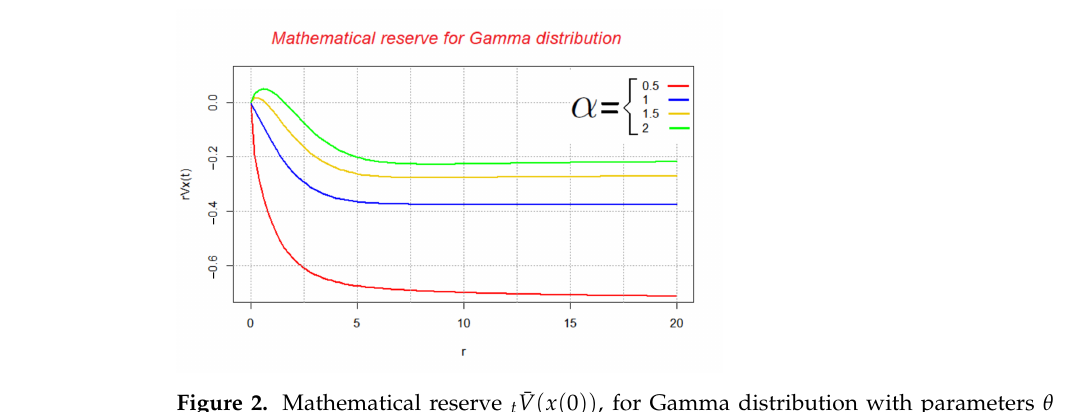
Figure 2. Mathematical reserve t ¯ V ( x ( 0 )) , for Gamma distribution with parameters θ = 1, and α = 0.5,1.0,1.5,2.0.